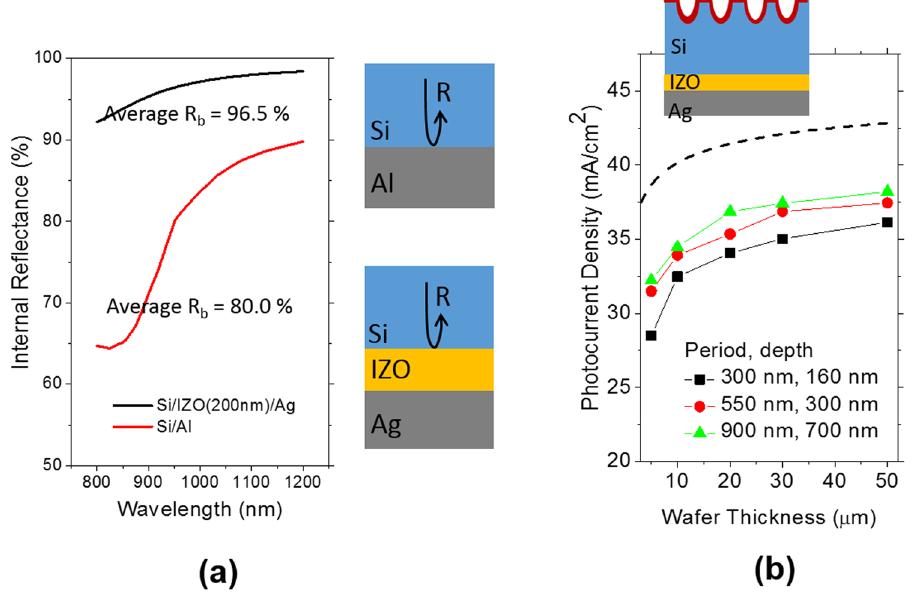
Figure 9. ( a ) Simulated internal reflectance spectra of two different interfaces of Si/Al and Si/IZO/Ag. The incident medium is assumed to have a refractive index of 3.5 which is that of crystalline Si. ( b ) Simulated photocurrents in the Si wafers with the nanohole arrays of different periods and depths as a function of the wafer thickness. The dashed line represents the Lambertian limit of the photocurrents.